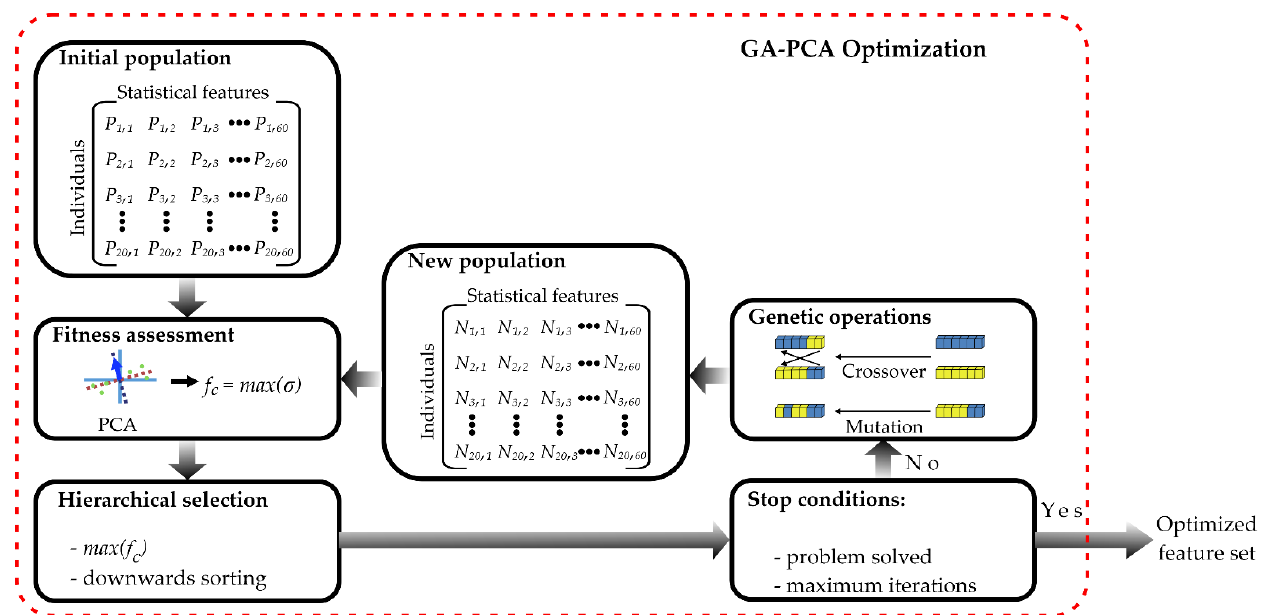
Figure 3. Block diagram for the GA-PCA feature optimization.